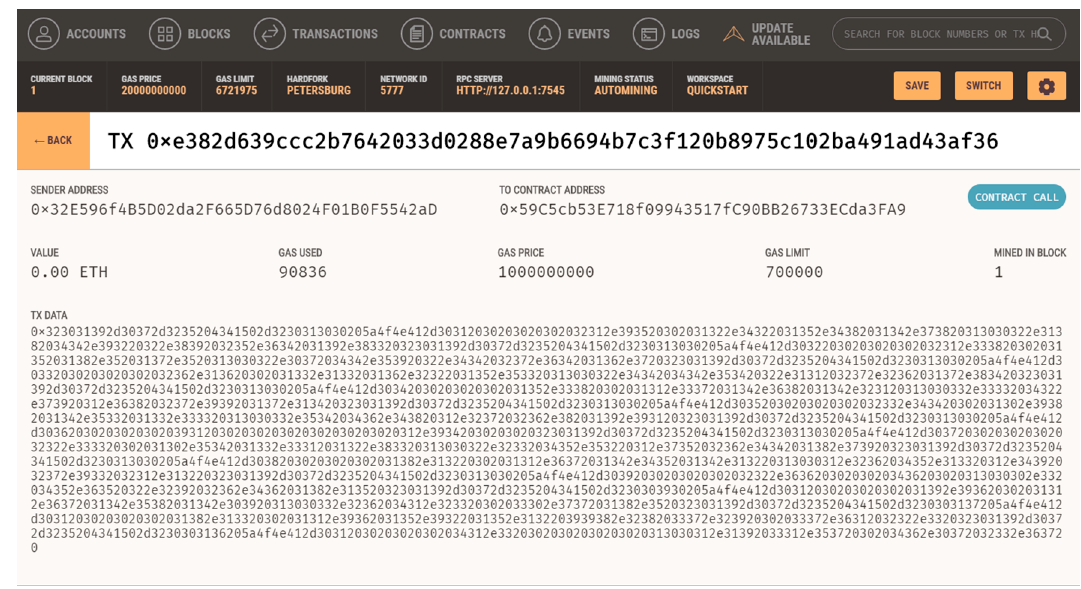
Figure 3. Transaction example.